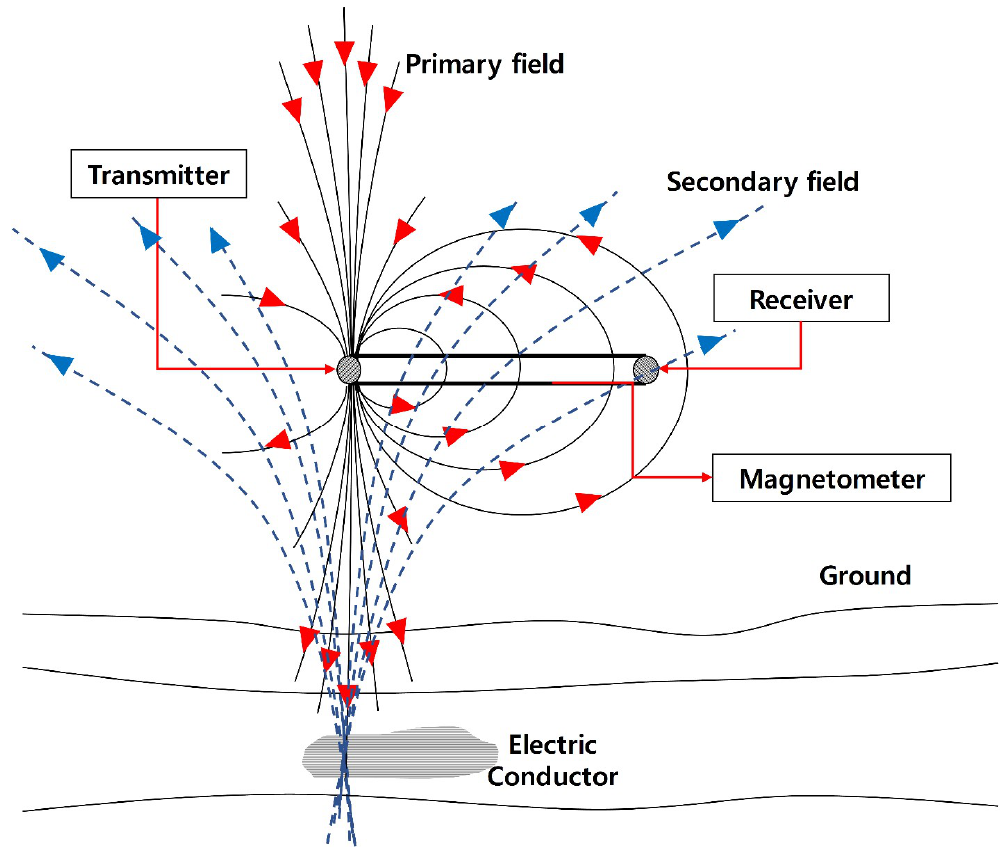
Figure 1. Conceptual diagram of the FDEM (frequency domain electromagnetic) survey.